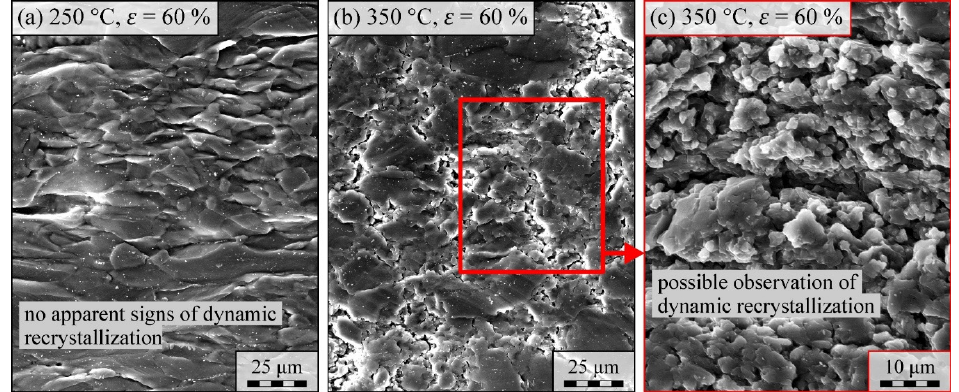
Figure 7. Comparison of the ( a ) 250 °C specimen to the ( b , c ) 350 °C in-situ simple tension test specimen where dynamic recrystallization reduced grain elongation and formed new grains along existing